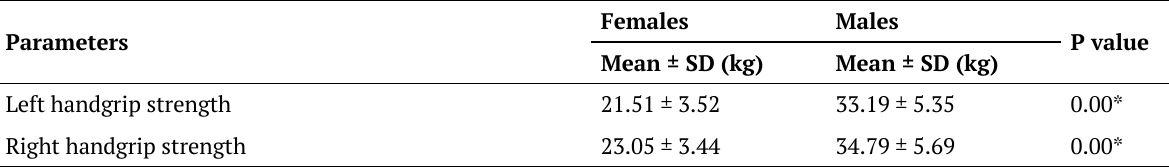
Females Males P value Mean ± SD (kg) Mean ± SD (kg)